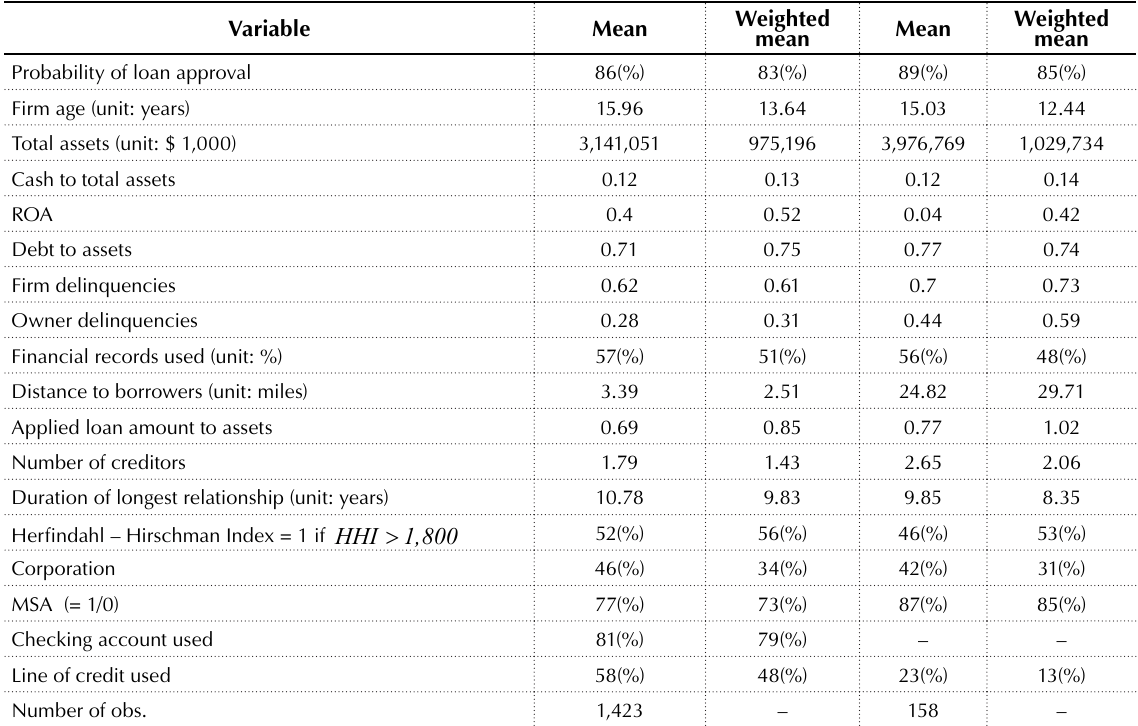
Table 1. Summary statistics for loan